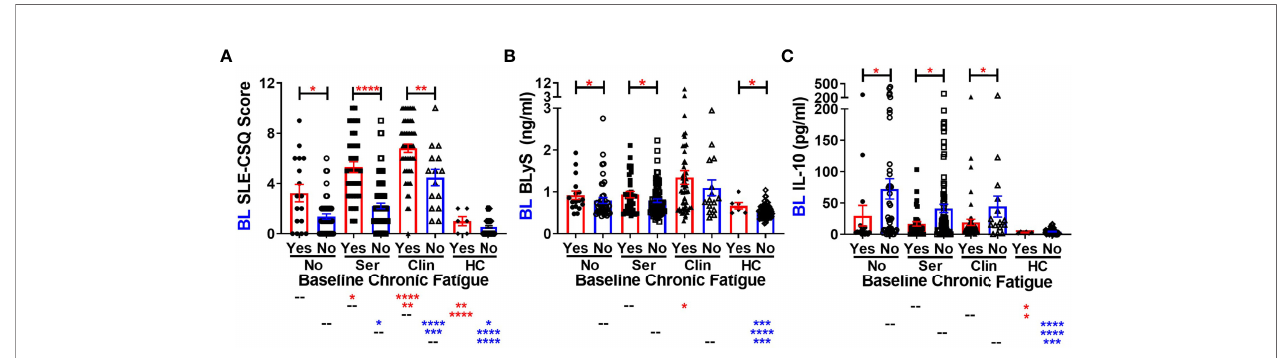
FIGURE 1 | Altered SLE-CSQ scores and BLyS and IL-10 levels associated with reported chronic fatigue in lupus relatives prior to disease transition in the LAUREL cohort. Lupus relatives in the LAUREL cohort at baseline meeting No ACR criteria (No), only serologic ACR criteria (Ser), or clinical ACR criteria (Clin) vs. matched, unaffected healthy controls (HC) who did (Yes) or did not (No) report chronic fatigue on the LFRR questionnaire were evaluated for (A) SLE-CSQ scores, (B) plasma BLyS levels, and (C) plasma IL-10 levels. Mean ± SEM. **** p<0.0001 ; *** p<0.001 ; ** p<0.01 ; * p<0.05 by Kruskal-Wallis with Dunn ’ s